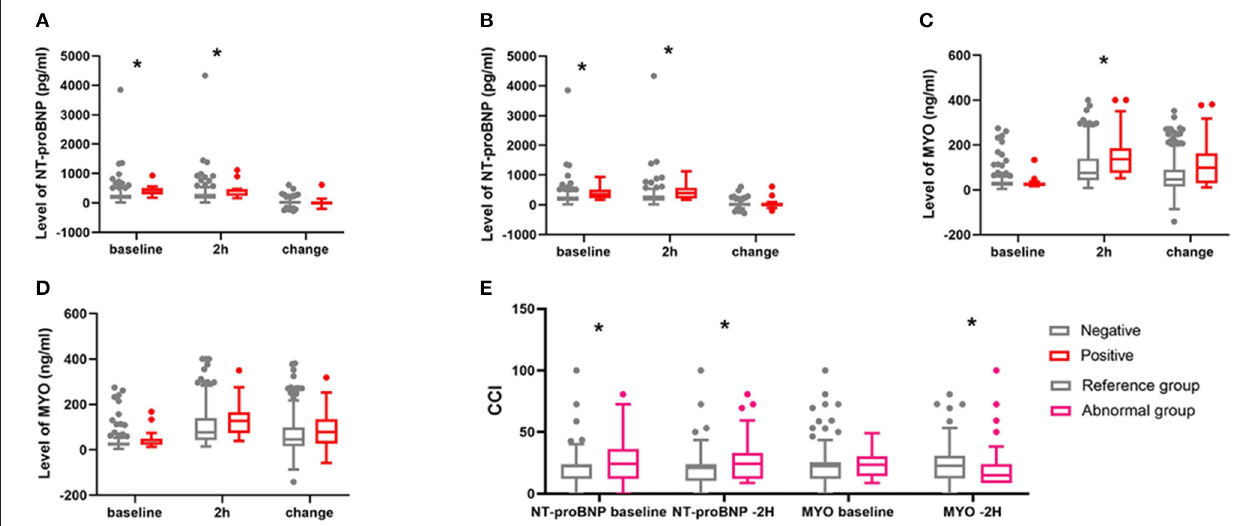
FIGURE 1 | Comparison of peri-operative concentrations of NT-proBNP and MYO between complication positive and complication negative patients and CCI between patients with reference and abnormal concentrations. (A) NT-proBNP for complications ≥ CDC grade 3, *indicates P < 0.001. (B) NT-proBNP for major complications, *indicates P < 0.001. (C) MYO for complications ≥ CDC grade 3. * P = 0.015. (D) MYO for major complication. (E) comparison of CCI between patients with reference concentrations and abnormal concentrations of NT-proBNP and MYO. * P < 0.005.